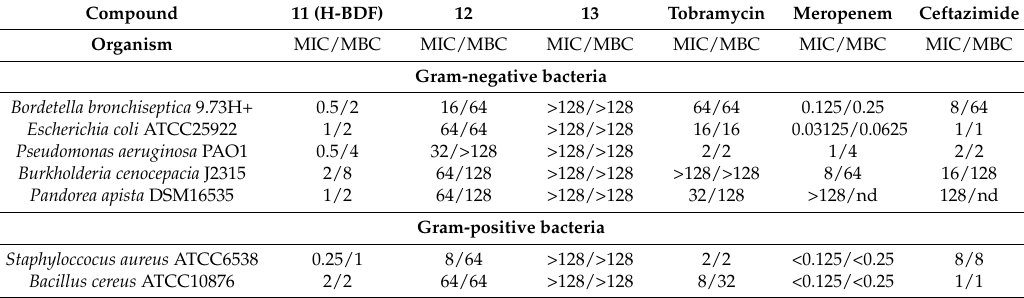
Table 2. Anitmicrobial activities of new compounds 11 , 12 and 13 against Gram-negative and Gram-positive bacteria—minimal inhibitory concentrations (MIC, µ g/mL) and minimal bactericidal concentration (MBC, µ